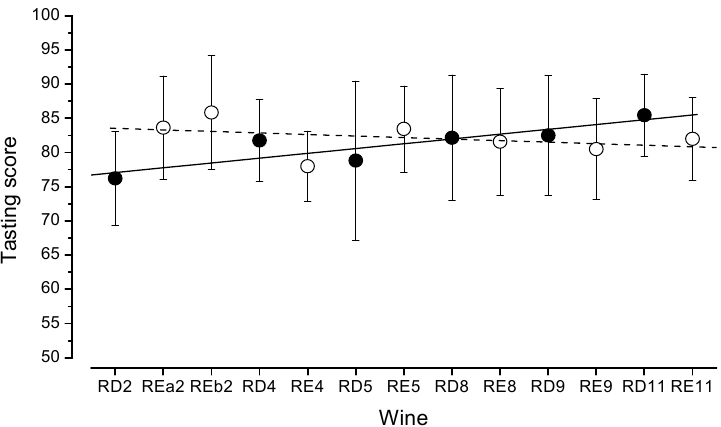
Figure 4. Evolution of the tasting scores given by the 2014 panel to red wines (“easy” wines, open symbols; “difficult” wines, filled symbols). Straight lines were obtained by linear regression of mean score values (“easy wines”, dashed lines; “difficult” wines, solid lines). Bars indicate standard deviations of the mean scores. Wine references are described in Table 4.